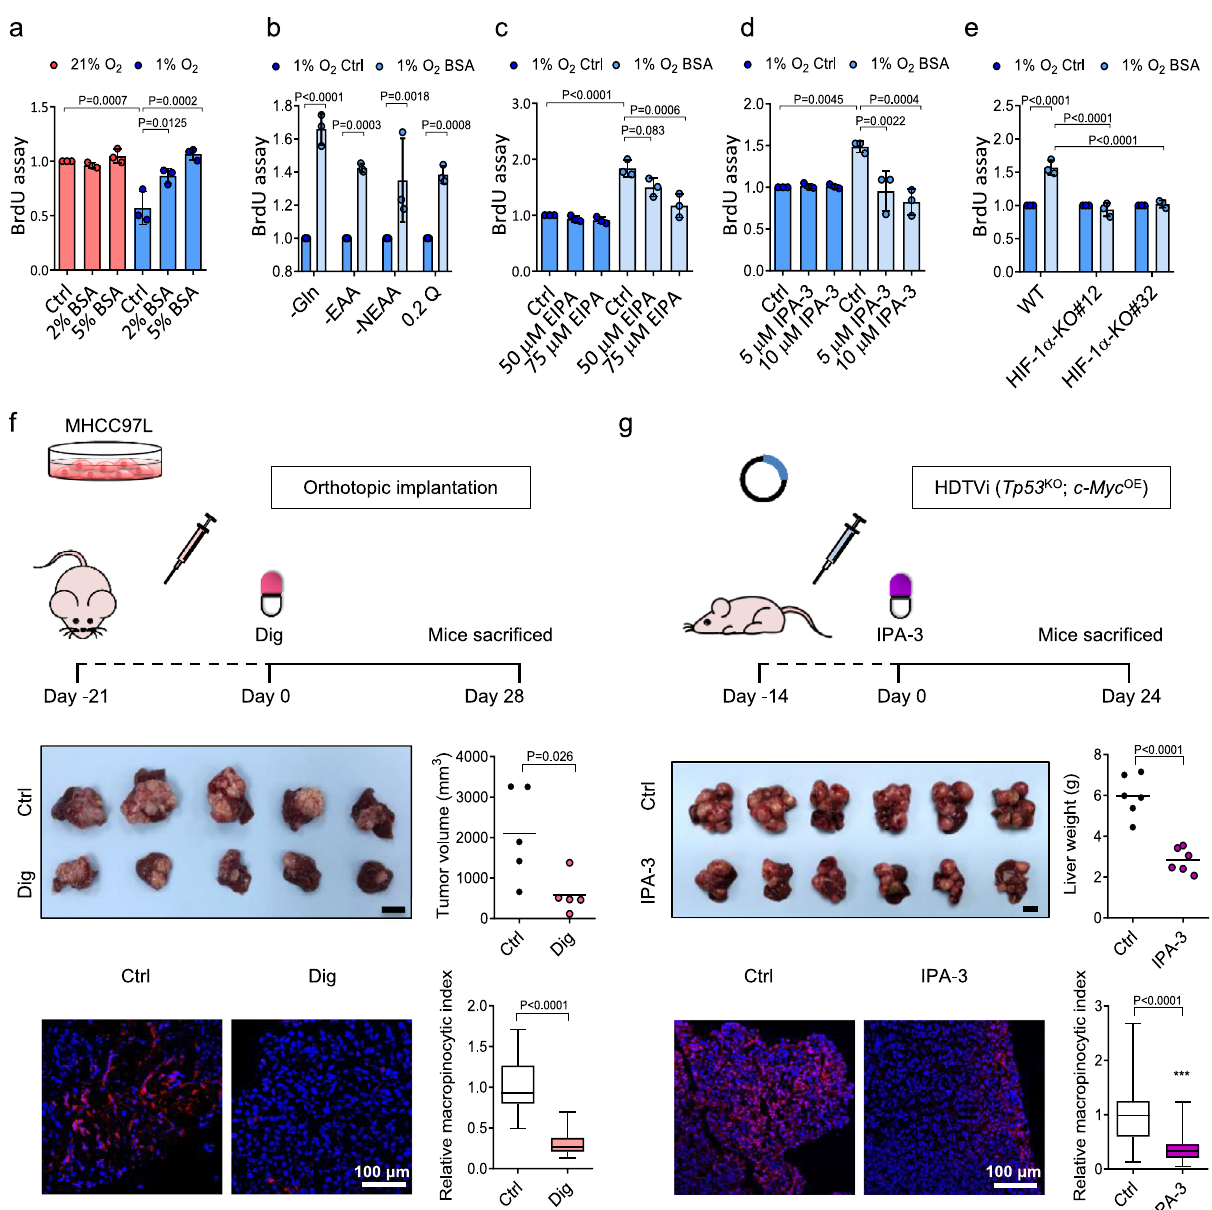
Fig. 2 Protein scavenging promotes hypoxic HCC cell growth. a Cell proliferation of MHCC97L cells cultured in 0.2 mM glutamine (0.2 Q) supplemented with increasing doses of BSA or vehicle control (Ctrl) in 21 and 1% O 2 . Values were normalized to 21% O 2 Ctrl. b Cell proliferation of MHCC97L cells cultured in glutamine-depleted (-Gln), essential amino acid-depleted (-EAA), nonessential amino acid-depleted (-NEAA), or 0.2 Q DMEM media in 1% O 2 treated with 5% BSA or vehicle control (Ctrl). c Cell proliferation of MHCC97L cells cultured in 10% AA-DMEM containing 5% BSA. Cells were treated with EIPA or vehicle control (Ctrl). d Cell proliferation of MHCC97L cells cultured in 10% AA-DMEM treated with IPA-3 or vehicle control (Ctrl). Cells were supplemented with 5% BSA or vehicle control (Ctrl). e Cell proliferation of MHCC97L wild type (WT), -HIF-1 α -KO#12, and -HIF-1 α -KO#32 cultured in 10% AA-DMEM treated with 5% BSA or vehicle control (Ctrl, PBS) under 1% O 2 condition. f Top: 6 – 8 week-old male BALB/cAnN-nude mice were orthotopically implanted with luciferase-labeled MHCC97L cells into the livers and received digoxin (dig) or vehicle-control (Ctrl) treatment for 28 days. Middle: Image of orthotopic HCC xenografts and tumor volumes of mice. Bottom: Confocal images show dextran uptake/macropinosomes (red) and nuclei (DAPI, blue) in HCC tissues. n = 5 biologically independent samples. g Top: Hydrodynamic tail-vein injection (HDTVi) of genome-editing systems was performed in 8 – 10-week-old male C57BL/6 N mice to induce Tp53 KO ; c-Myc OE mouse HCC. Mice received IPA-3 or vehicle control (Ctrl) treatment for 24 days. Middle: Image of HCC and liver weights of mice. Bottom: Confocal images show dextran uptake/macropinosomes (red) and nuclei (DAPI, blue) of HCC tissues. n = 6 biologically independent samples. a – e Results were from 3 independent experiments. b – e Values were normalized to 1% O 2 Ctrl. f , g Scale bars, 1 cm. Macropinocytic indexes were normalized to Ctrl. Error bars indicate mean ± SD. Scatter plot: center line, mean. Box-and-whisker: center line, median; box limits, 25th to 75th percentiles; whiskers, min – max. a – e Two-way ANOVA with Bonferroni correction. f , g Two-tailed Student ’ s t -test. Source data are provided as a Source Data fi le.